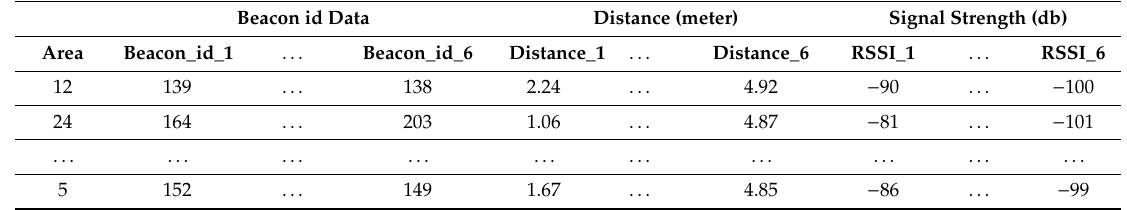
Table 4. Structure of the collected dataset in the fingerprinting o ffl ine phase.